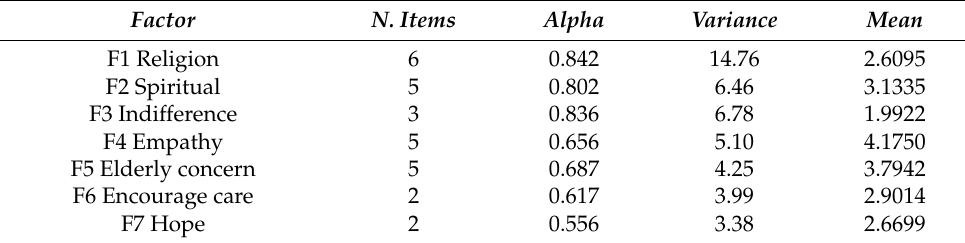
Table 1. Outcomes from factor analysis with Varimax rotation: 7 factors extracted. Factor N.